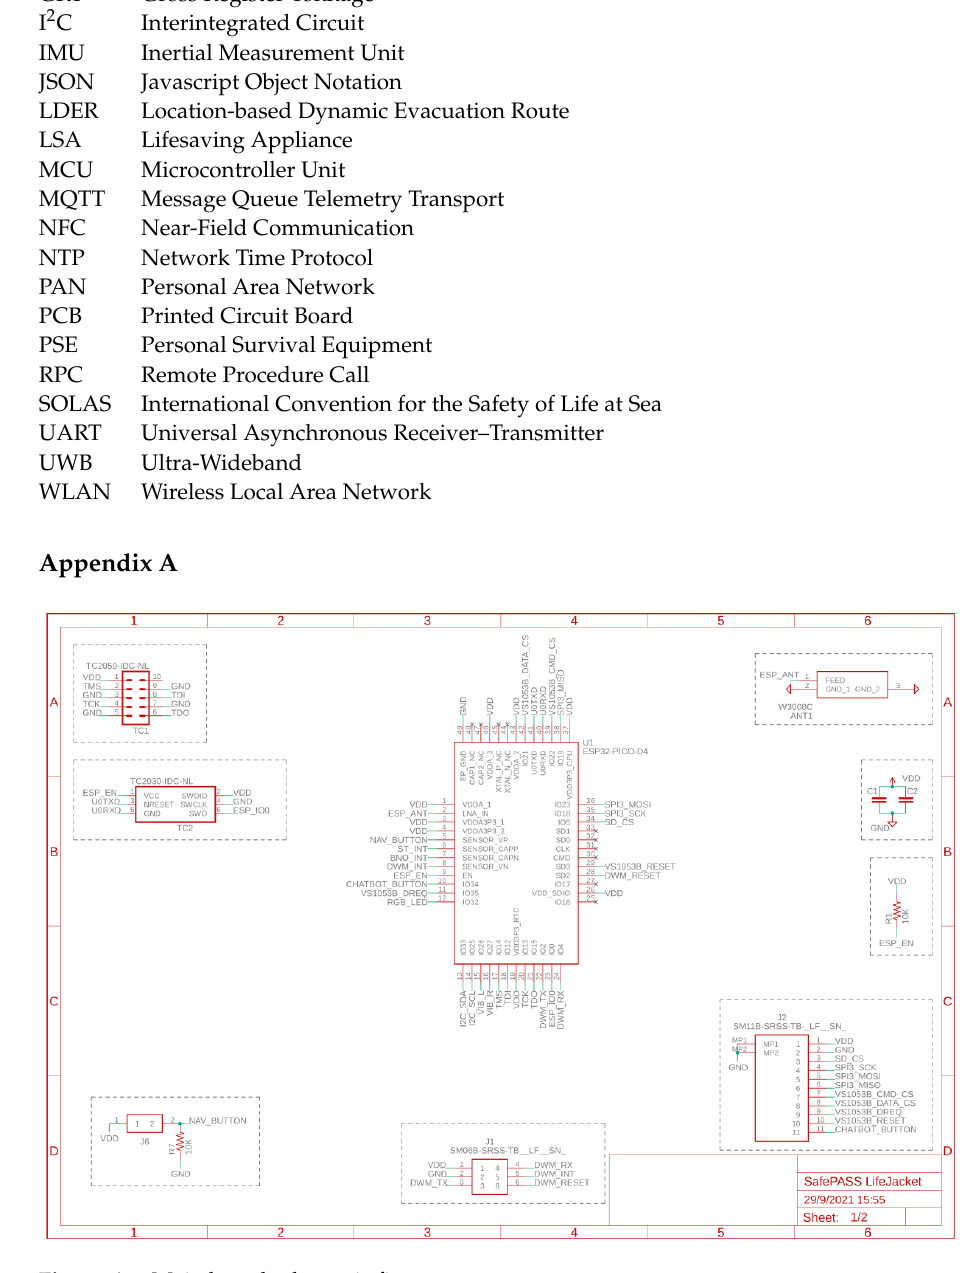
Figure A1. Main board schematic first part.